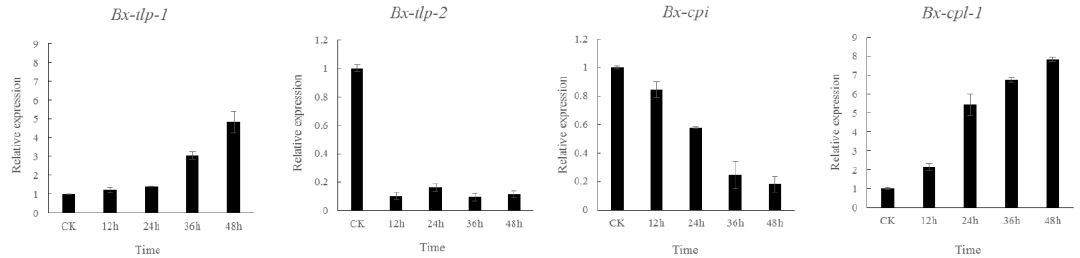
Figure 6. Gene expressions of Bx-tlp-1 , Bx-tlp-2 , Bx-cpi and Bx-cpl-1 . CK—controls; 12 h—soaked for 12 h; 24 h—soaked for 24 h; 36 h—soaked for 36 h; 48 h—soaked for 48 h. There were three biological replications for each experiment. The error line means standard deviation of the mean.